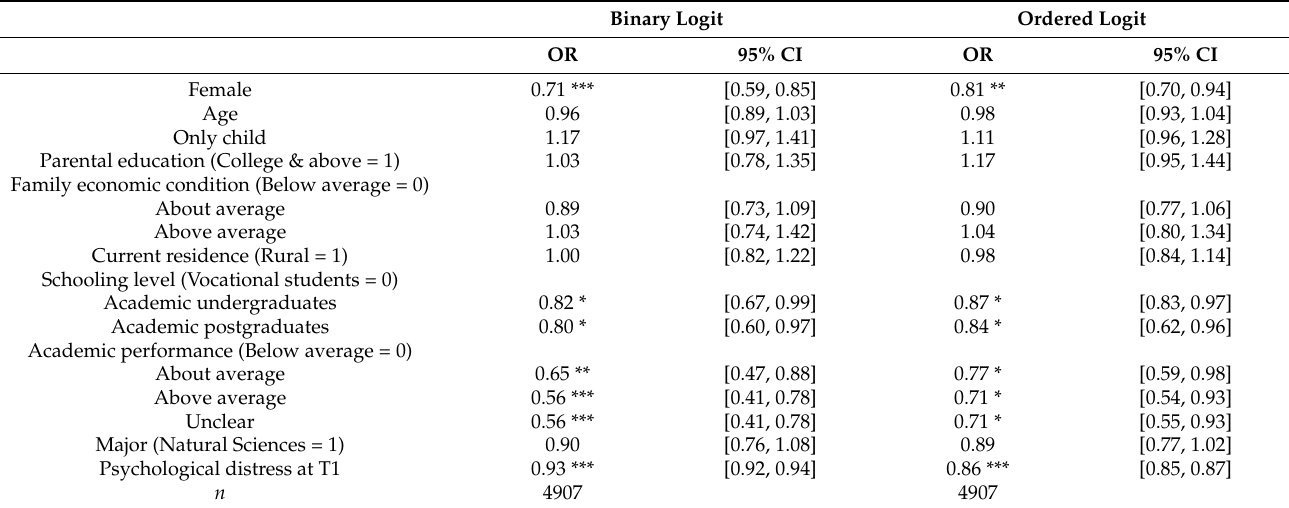
Table 3. Logit models estimating family and education background on individual change in psycho- logical distress over the follow-up period. Binary Logit Ordered